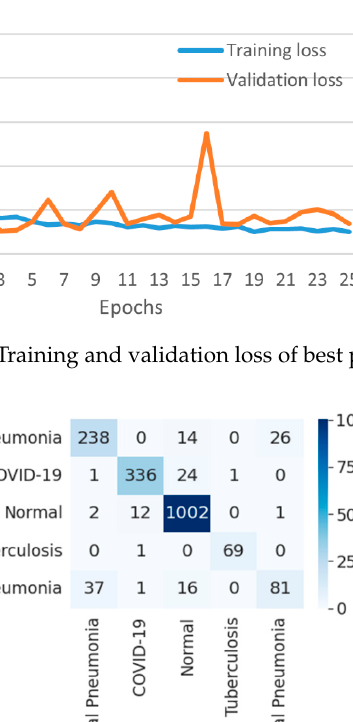
Figure 19. Training and validation accuracy of best performing VGG16 model for five-class.